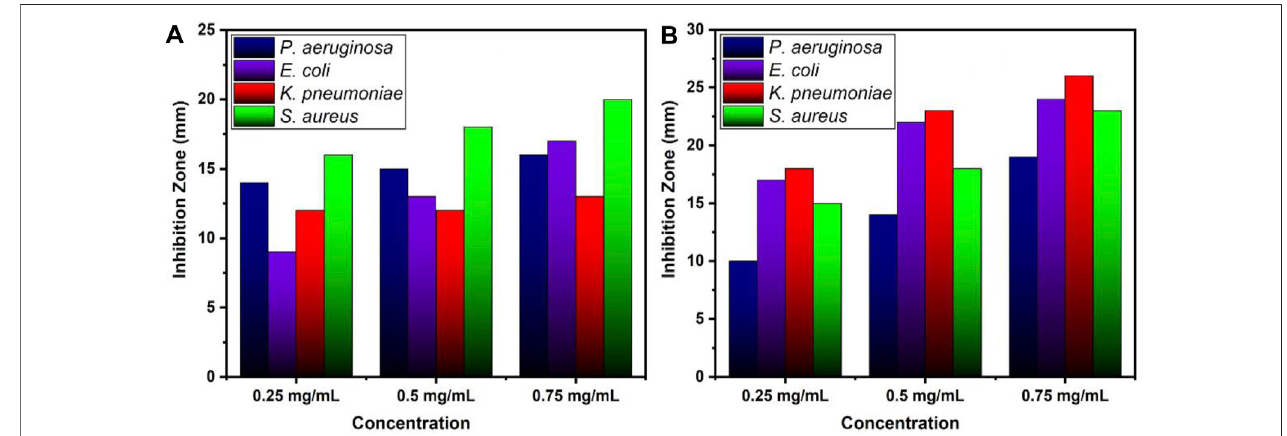
Frontiers in Chemistry |